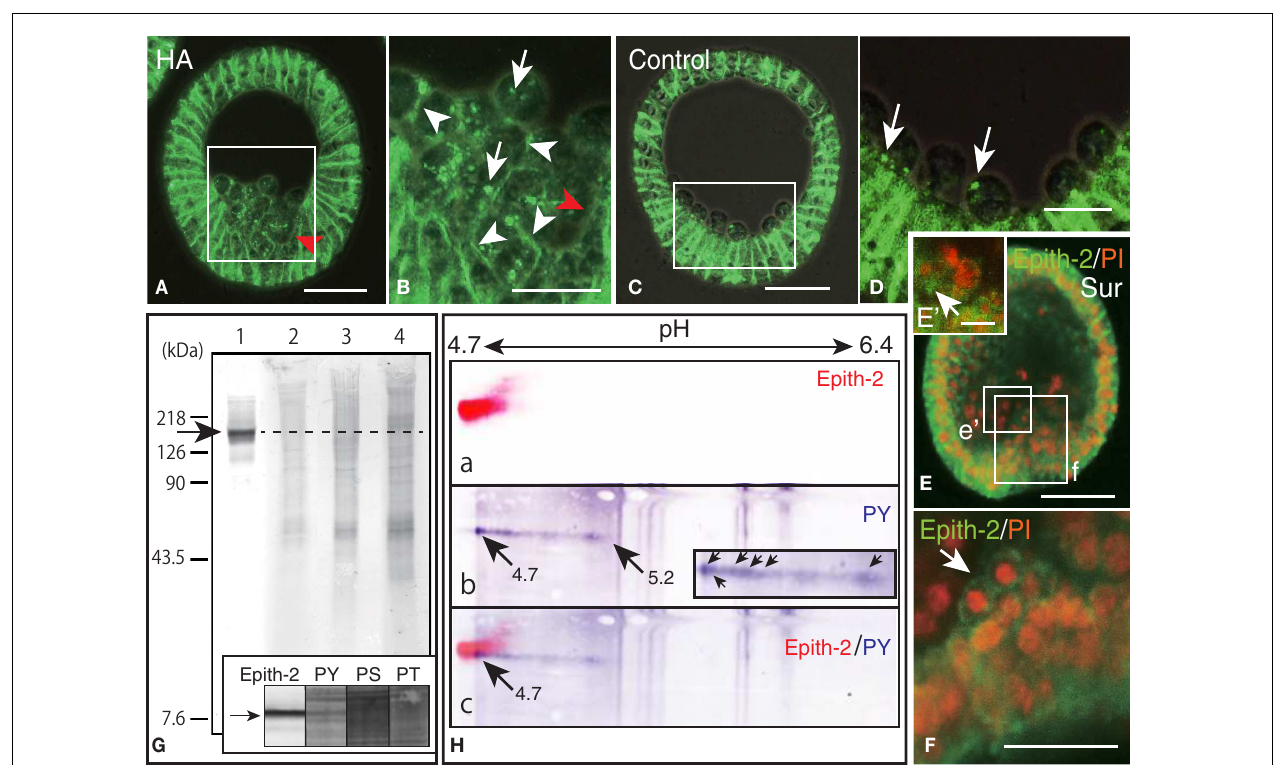
bar, 40 µ m. (E’) Higher magnification of the box (e’) in (E) . Arrow, Epith-2 cell. Scale bar, 5 µ m (F) Higher magnification image of the box (f) in (E) . Arrow, aggregated PMCs. Scale bar, 20 µ m. ( G ) Epith-2 phosphorylation in swimming blastulae by immunoblotting. Lane 1; anti-Epith-2 mAb, lane 2; anti-phosphotyrosine (PY) antibody (Ab), lane 3; anti-phosphoserine (PS) Ab, and lane 4; anti-phosphothreonine (PT) Ab. Arrow and dotted line denote the 143kDa region. Inset; immunoblotting with antibodies against Epith-2, phosphotyrosine (PY), phosphoserine (PS), and phosphothreonine (PT) using single-lane SDS-PAGE gel. Arrow, 143kDa region. (H) Phosphotyrosine detection by immunoblotting in Epith-2 of swimming blastulae by isoelectric points and molecular mass in Daltons. (a) Anti-Epith-2 mAb. Artificially colored with red. (b) Anti-PY Ab. Artificially colored with blue. Inset, higher magnification of tail region. Arrows, anti-PY Ab-positive dots. (c) Merged image between (a,b) . Numbers on the top show the pH gradient from the left (4.7) to right